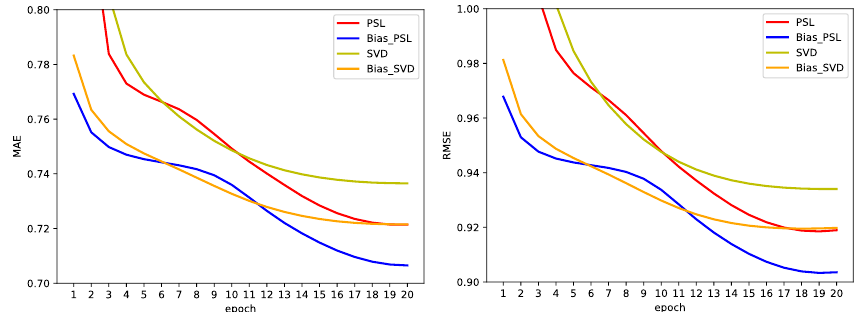
Figure 3. Training process of compared models on MovieLen-100 K with 100 latent factors.